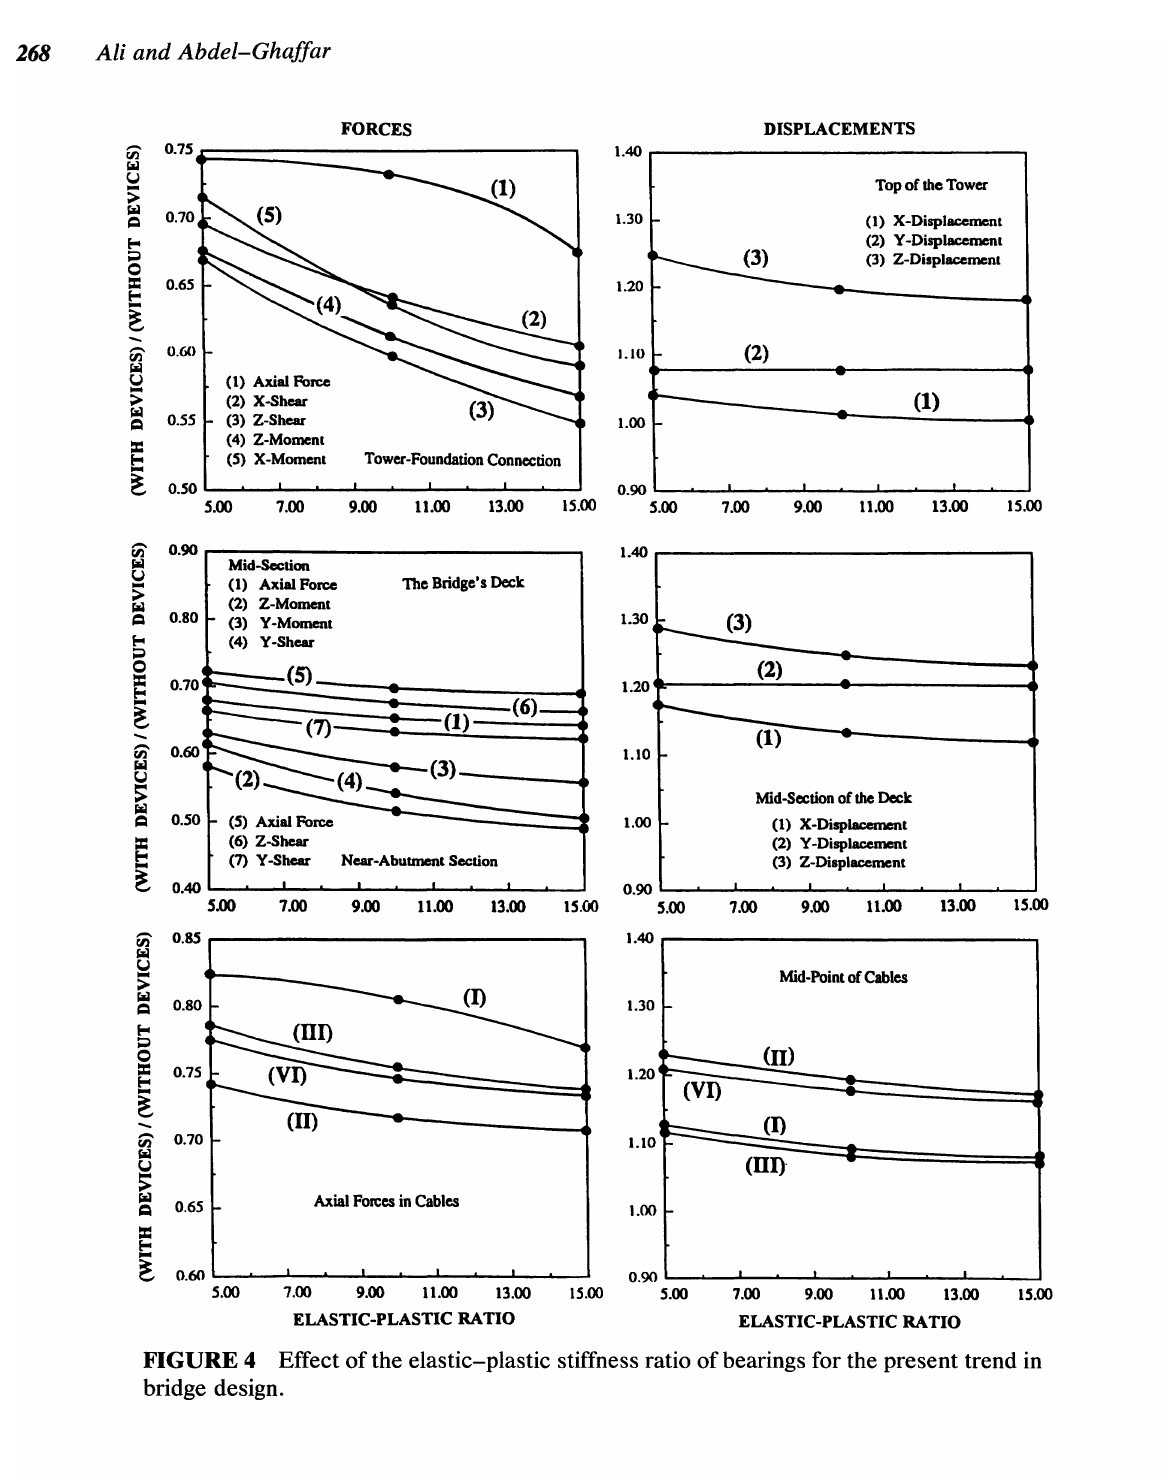
FIGURE 4 Effect of the elastic-plastic stiffness ratio of bearings for the present trend in bridge